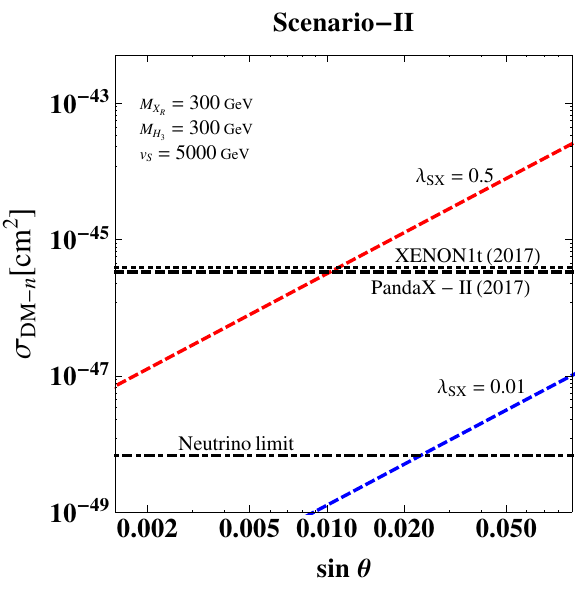
Figure 5 . DM-Nucleon scattering cross section as a function of sin (cid:18) in Scenario-II where we take m X = 300 GeV, m H = 300 GeV, v S = 5000 GeV and (cid:21) SX = 0 : 5(0 : 01) for red(blue) line as 3 reference values. The current bounds from XENON1T [32] and PandaX-II